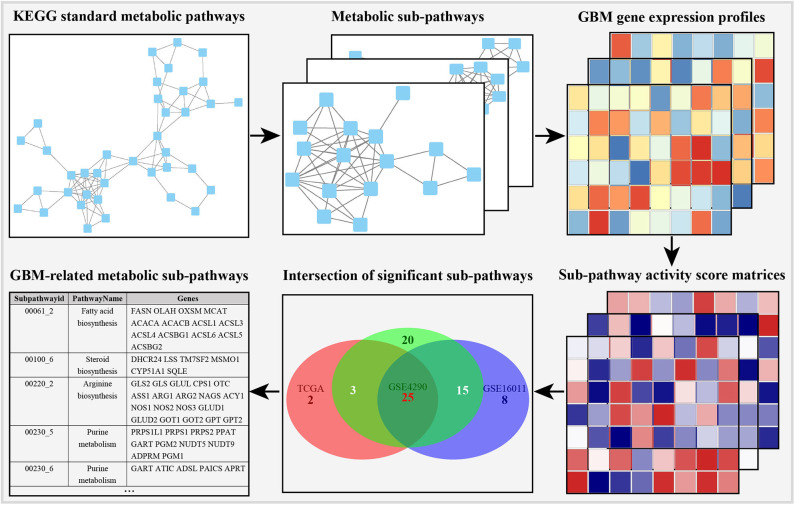
Outline of identification of GBM-related metabolic subpathways.